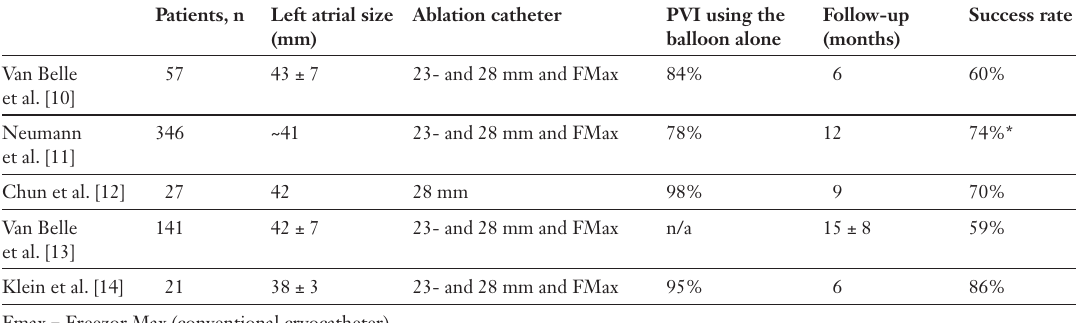
Outcomes of cryo- balloon ablation in previous